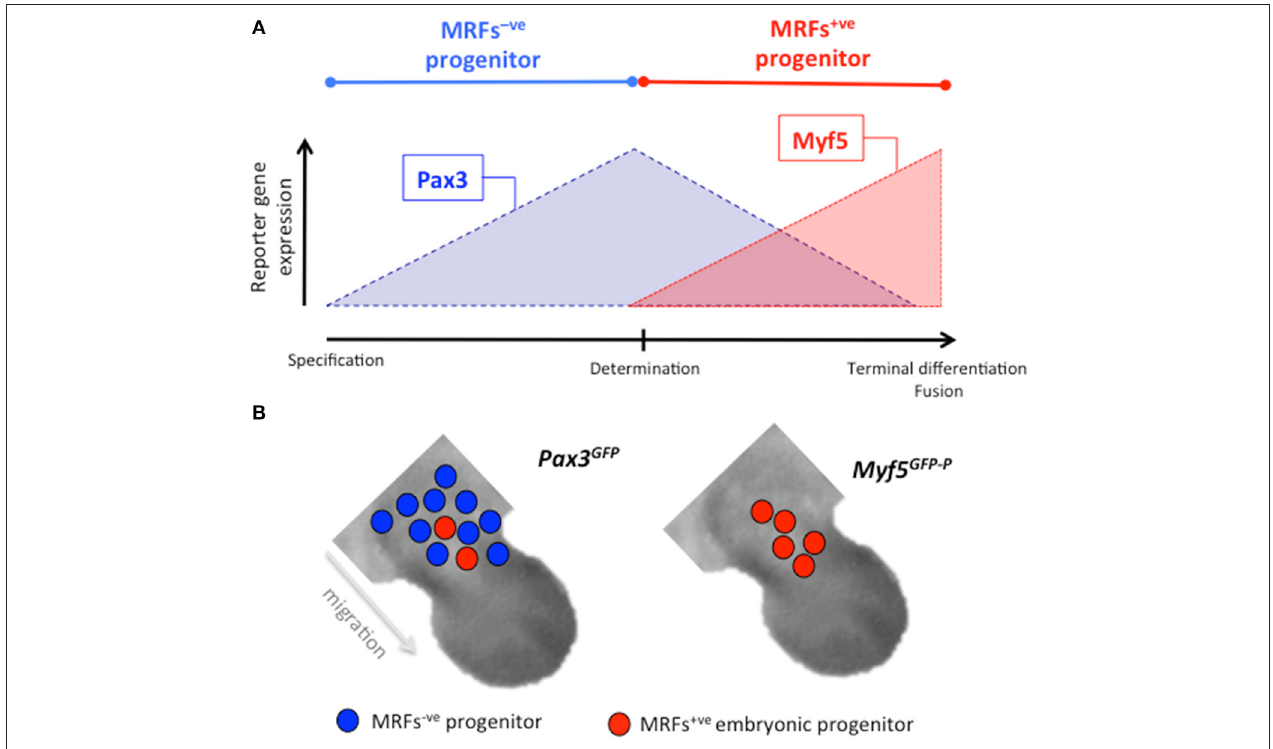
FIGURE 2 | Discrimination between progenitors with different degree of differentiation. (A) Schematic representation showing the expression of the reporter GFP in Pax3 GFP and Myf5 GFP − P mice during the myogenic lineage progression at the embryonic stage. Different steps of the lineage progression leading to terminal differentiation are indicated on the x-axis. (B) Representation of the numerical proportion and position of MRFs − ve and MRFs + ve progenitors expressing GFP in limbs of Pax3 GFP and Myf5 GFP − P at E11.5. Note that only in the Pax3 GFP embryos GFP is expressed in migrating MRFs − ve